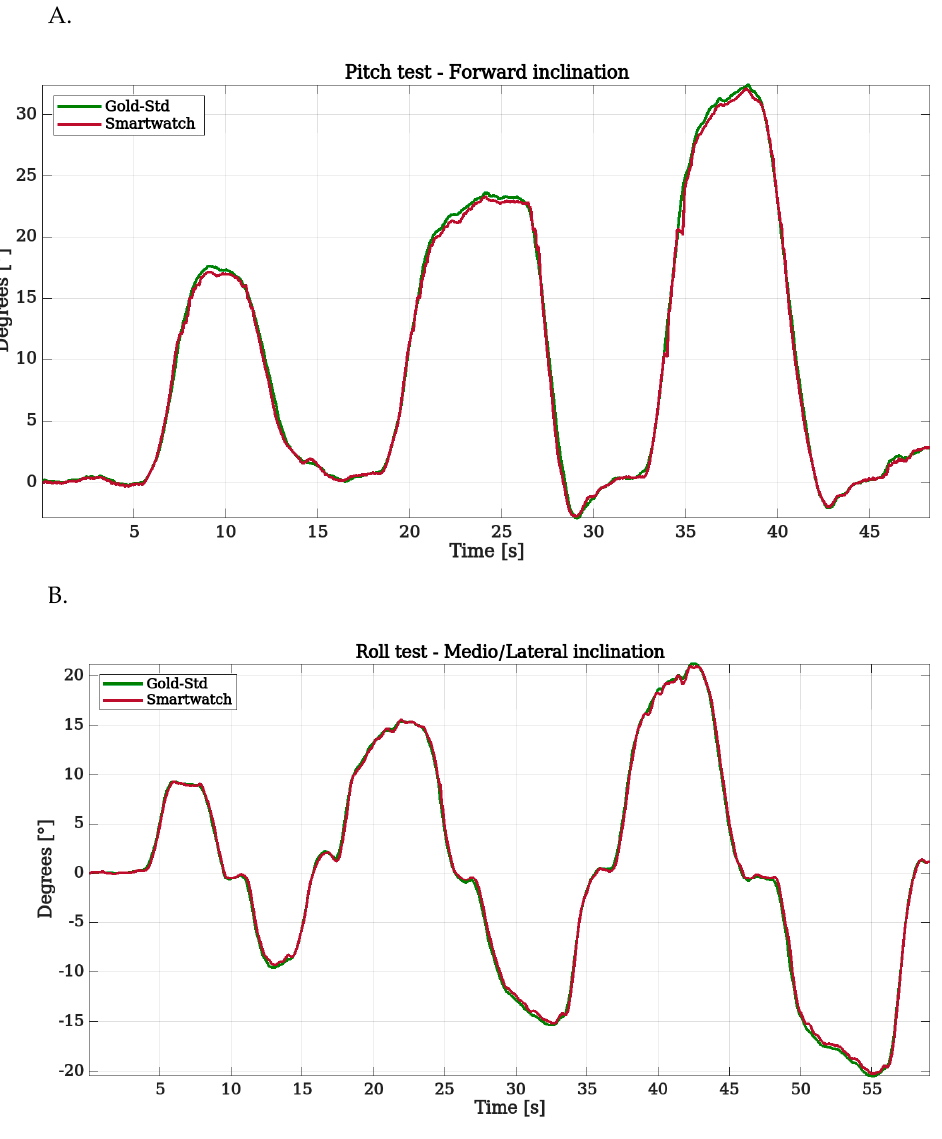
Figure 11. ( A ). Qualitative sensor validation for the pitch angle ( θ ). ( B ). Qualitative sensor validation for the roll angle ( ϕ ).